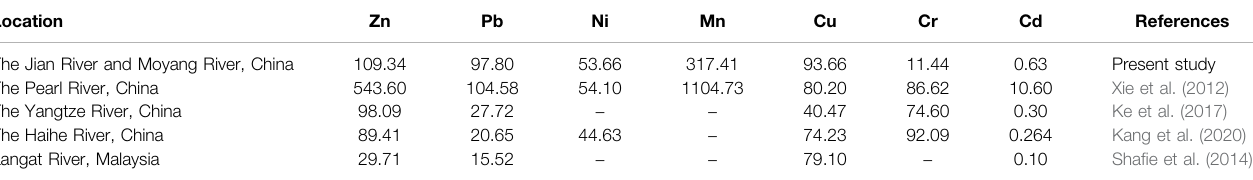
TABLE 3 | Metal concentrations (mg/kg) in the Jian and Moyang rivers compared with the mean sediment concentrations reported previously. Location